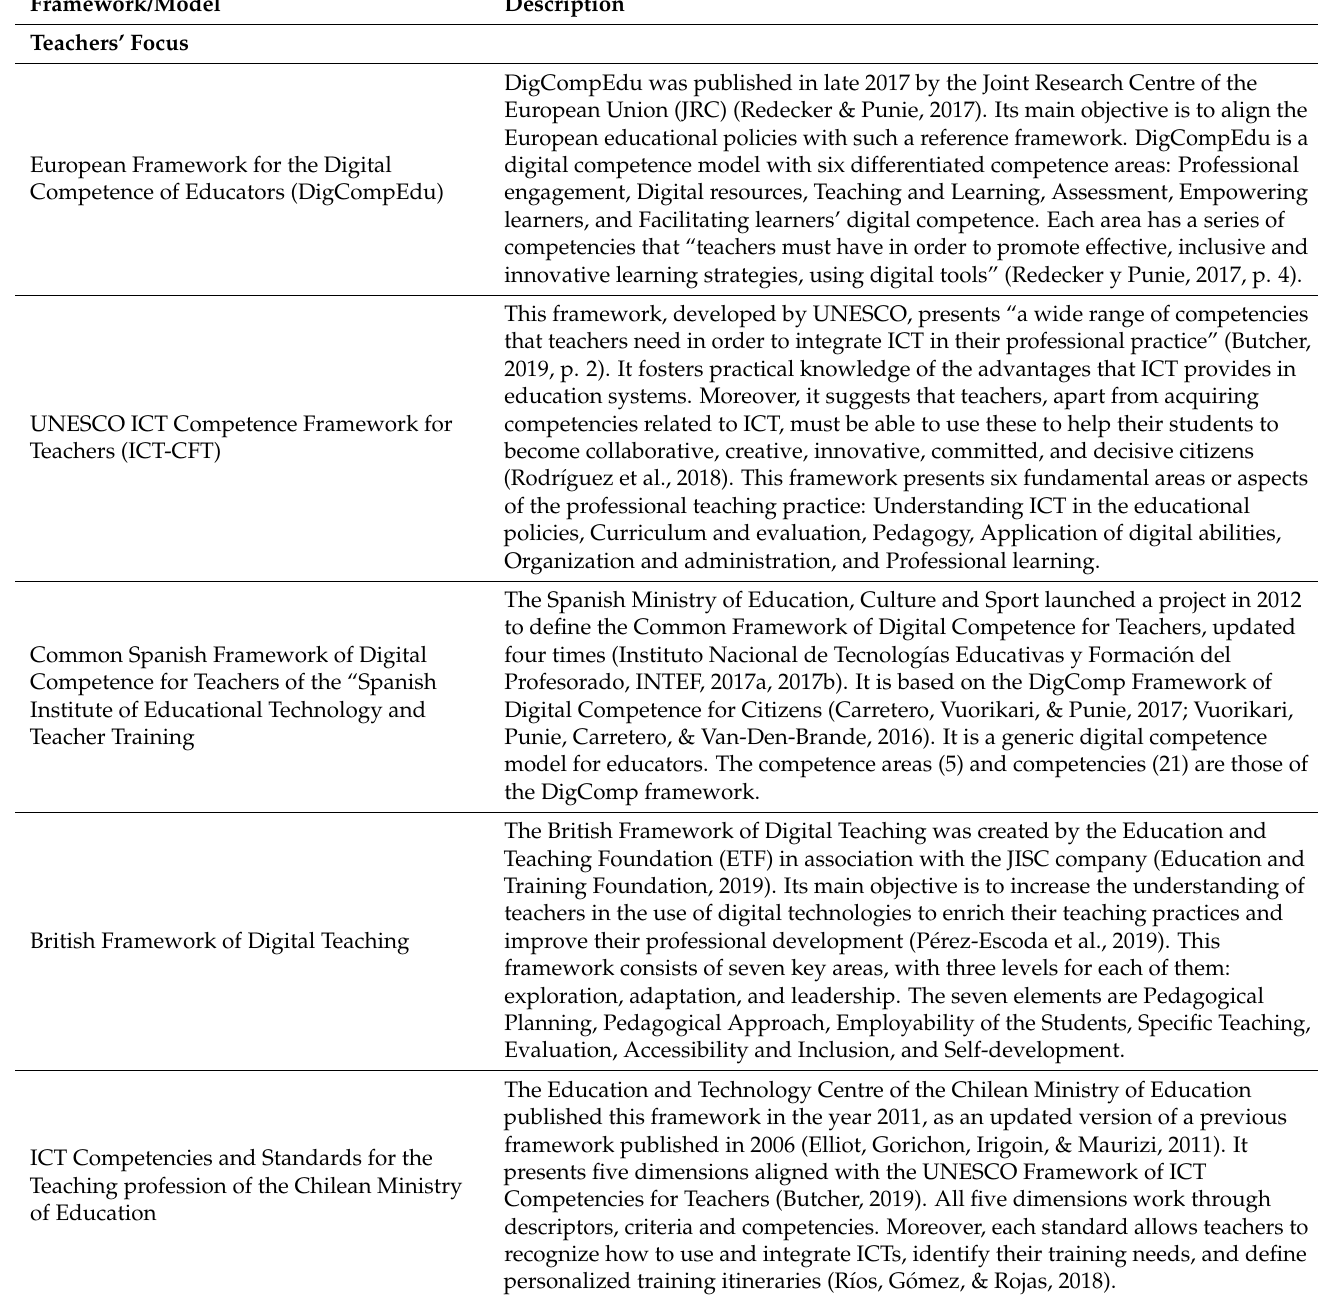
Table A1. Analysis of the different models for supporting competencies of Teaching and Learning Centers (TCLs) most referred in the